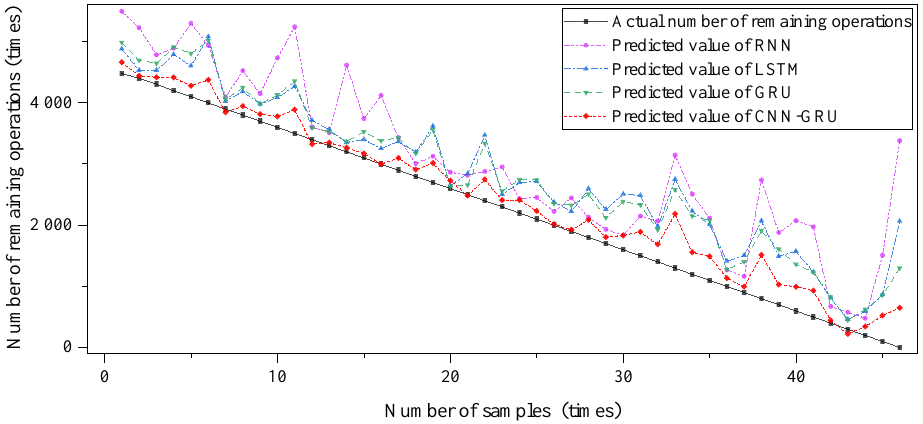
Figure 23. Sampling comparison diagram of prediction